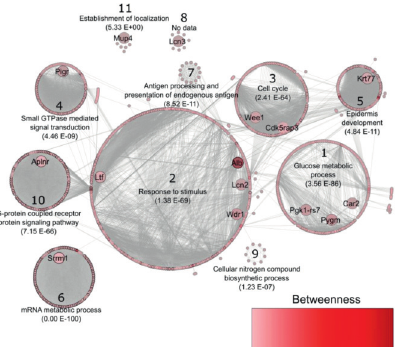
Figure 3: Interaction network of Mus musculus proteins homologous to those identified in Felis catus . Betweenness value represented by the color of the nodes, the lightest being the lowest value and the darkest being the highest value. It represents the ability of the node to join several clusters, or groups of nodes. Proteins with an elevated betweenness value have a high interaction with other proteins and are called bottleneck proteins. The width of the border of the nodes represents the value of node degree, so that the greater the width of the border, the greater the value and vice versa. The node degree property represents the number of connections that cross a single node, and the proteins with an above average node degree value are called hubs, which have an important regulatory function in the network. The clusters are subsets of nodes that are mostly connected to each other. In Figure 3, we have 11 clusters, each grouped in numbered circles. For each cluster, a biological process was assigned with the lowest corrected p value, according to the BiNGO tool. Therefore, in this network figure, for each cluster, the biological function, the number of the cluster, and its p value were indicated (the closer to zero, the more reliable). No annotation data were generated for cluster 8 (no data). Table 2: Mus musculus proteins homologous to the proteins identified in the tear film of cats ( Felis catus ). Uniprot/NCBI ID ( F. catus ) a